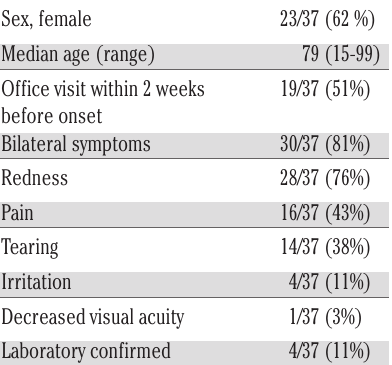
Table 1. Demographic and clinical charac- teristics of Epidemic keratoconjunctivitis patients seen at practice A.